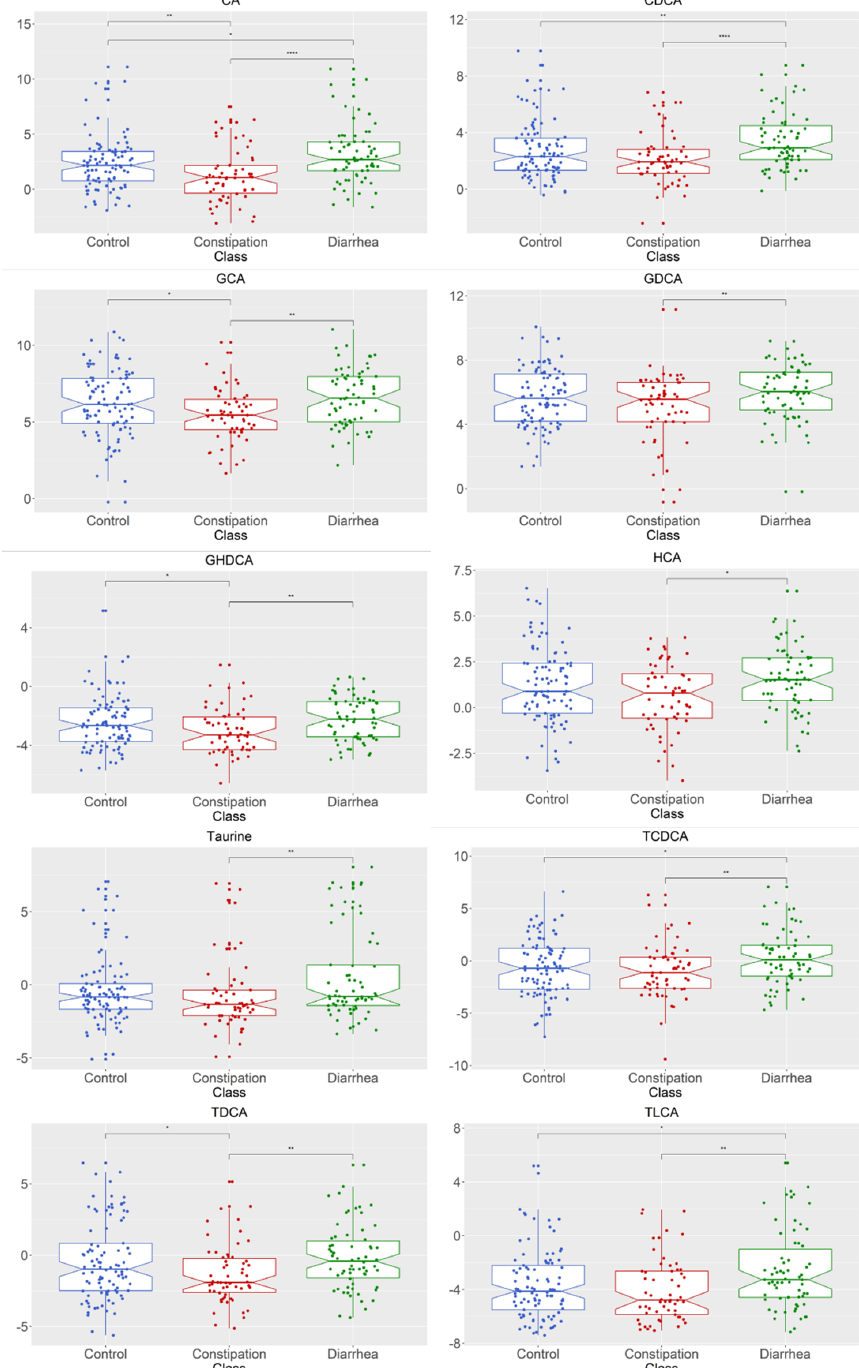
Figure 4. Bile acid metabolite distributions between healthy control, constipation (FC + IBS-C) group, and diarrhea (FD + IBS-D) group for metabolites with significantly different abundances between groups. Data presented as logged values of µg/mg. Boxplots show median (center line), 25th and 75th percentile (top and bottom of boxes, respectively), with whiskers representing 1.5 times the inter-quartile range, and boundaries of notches show 95% confidence interval (CI). Statistical significance denoted as p < 0.05 (*), p < 0.01 (**), p < 0.0001 (****). Abbreviations: cholic acid (CA); chenodeoxycholic acid (CDCA); glyco-cholic acid (GCA); glyco-deoxycholic acid (GDCA); glyco-hyo-deoxycholic acid (GHDCA); hyo-cholic acid (HCA); tauro-cheno-deoxycholic acid (TCDCA); tauro-deoxycholic acid (TDCA); tauro-lithocholic acid (TLCA). Constipation group is defined as individuals with both functional constipation and IBS-C. Diarrhea group is defined as individuals with both functional diarrhea and IBS-D.